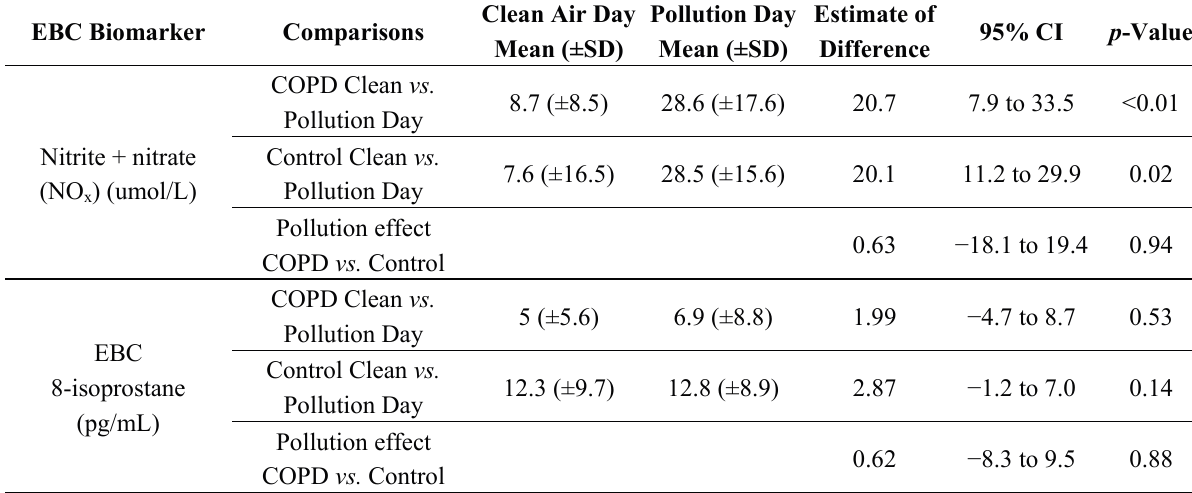
Figure 2. Exhaled breath condensate (EBC) nitrite + nitrate (NO x ) between pollution and clean air testing days. Box-and-Whisker plots shows the distribution of exhaled breath condensate (EBC) nitrite + nitrate (NO x ) between pollution and clean air testing days classified by COPD versus Control groups. Black filled dots represent mean of EBC nitrite + nitrate (NO x ). Black filled squares represent the outliers (above maximum value). The “whisker” represents minimum and maximum values. The box plot goes from upper (75) percentile, median and lower (25) percentile of the values. Table 5. EBC biomarker results on clean air quality vs. pollution